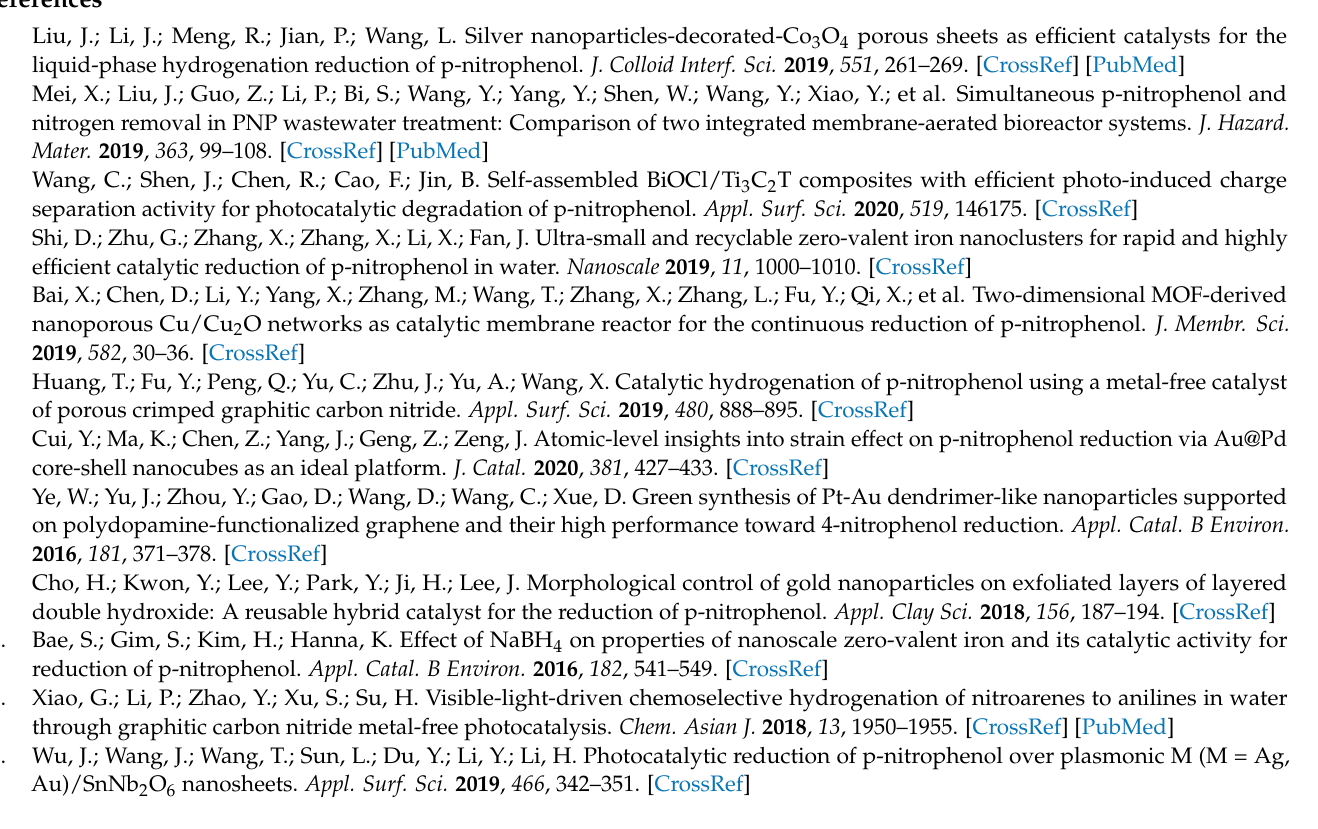
Figure S1: EDS element mapping of gCN-FePc-1; Figure S2: The XPS survey spectrum of gCN-FePc-1; Figure S3: UV-vis absorption spectra of p -NP solution before and after adding N 2 H 4 ; Figure S4: The liquid chromatograms of p -NP solution after photocatalytic reaction, the initial p -NP solution and the p -AP standard solution; Figure S5: The liquid chromatograms of p -NP solutions before and after different treatments; Table S1: The composition of p -NP solutions before and after different conditions analyzed by